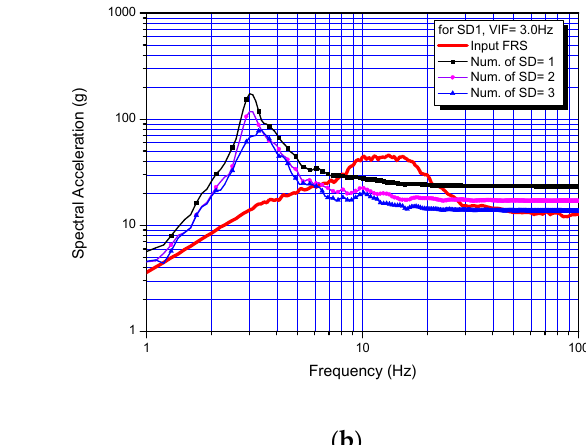
Figure 21. Results of vertical response spectrum for steel damper, SD1: ( a ) Design VIF = 2.5 Hz; ( b ) design VIF = 3.0 Hz.